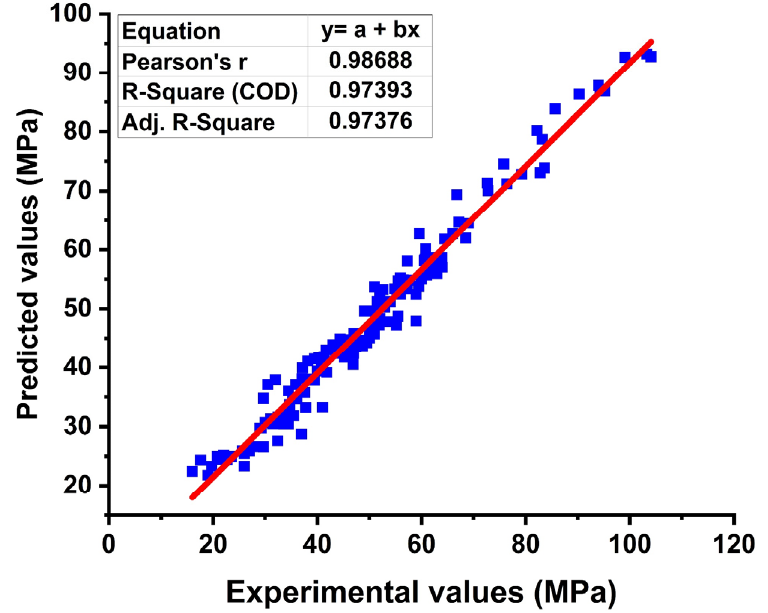
Figure 7. Regression analysis of training set of MEP.